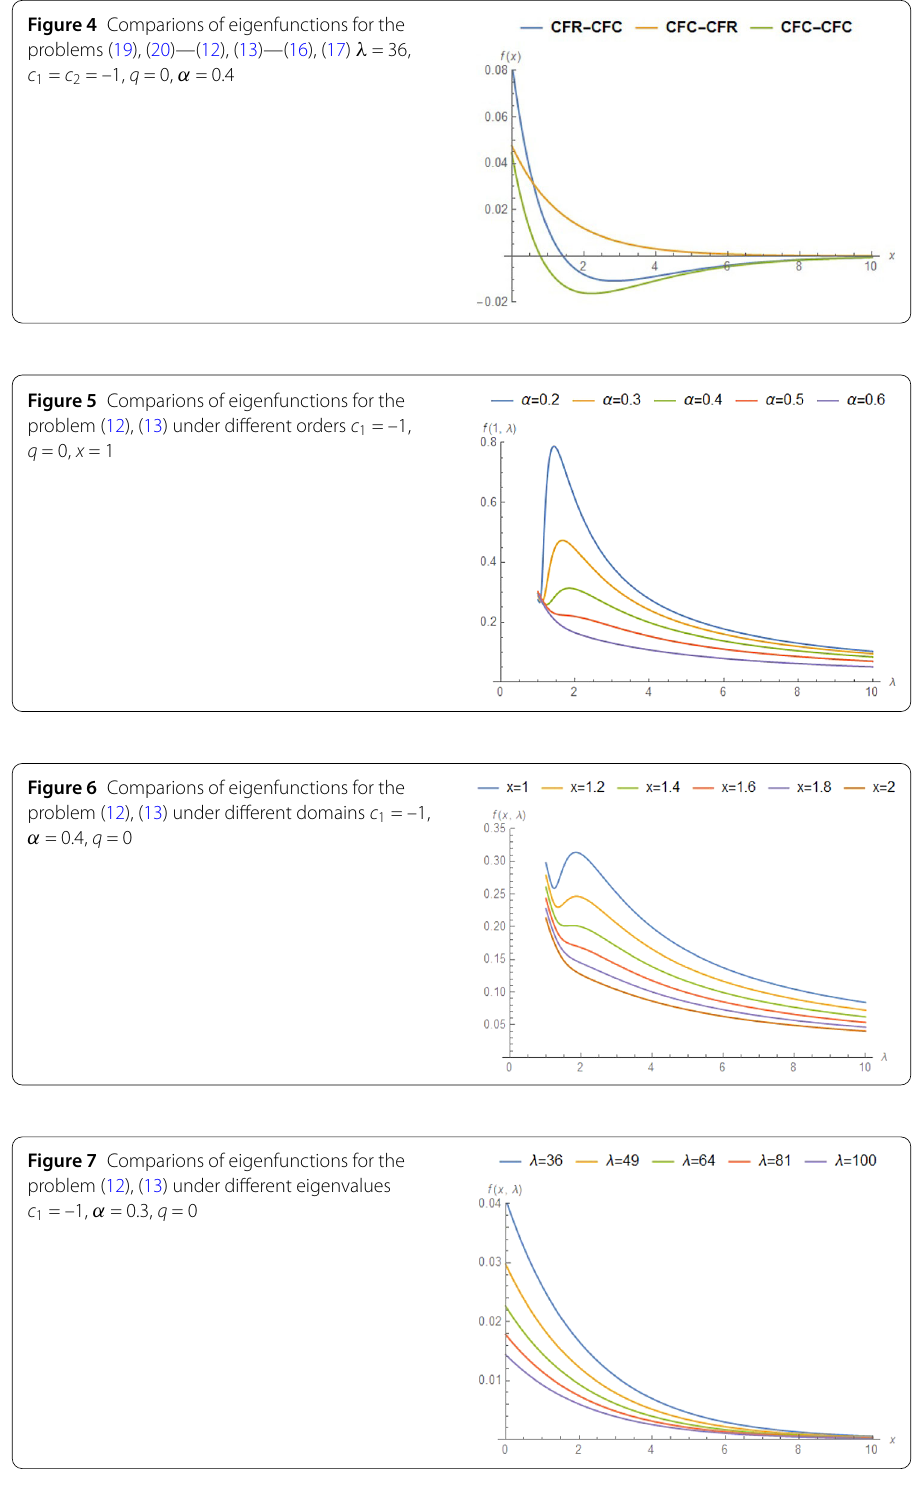
Figure 4 Comparions of eigenfunctions for the problems (19), (20)—(12), (13)—(16), (17) λ = 36, c 1 = c 2 = –1, q = 0, α = 0.4